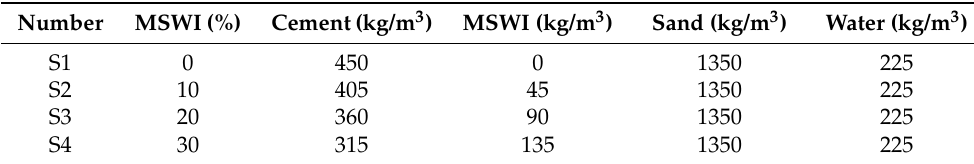
Table 3. Mix proportion of chloride ion erosion tests of MSWI